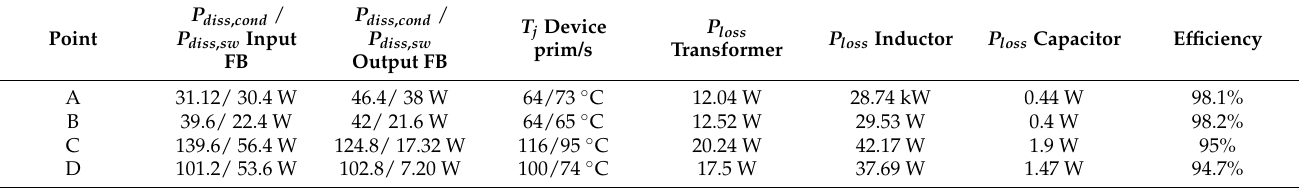
Table 7. Main results of thermal simulations for the operating points specified in Figure 8. The power dissipations in columns one and two are comprehensive of the four switches of the input and output full bridge (FBs), respectively.